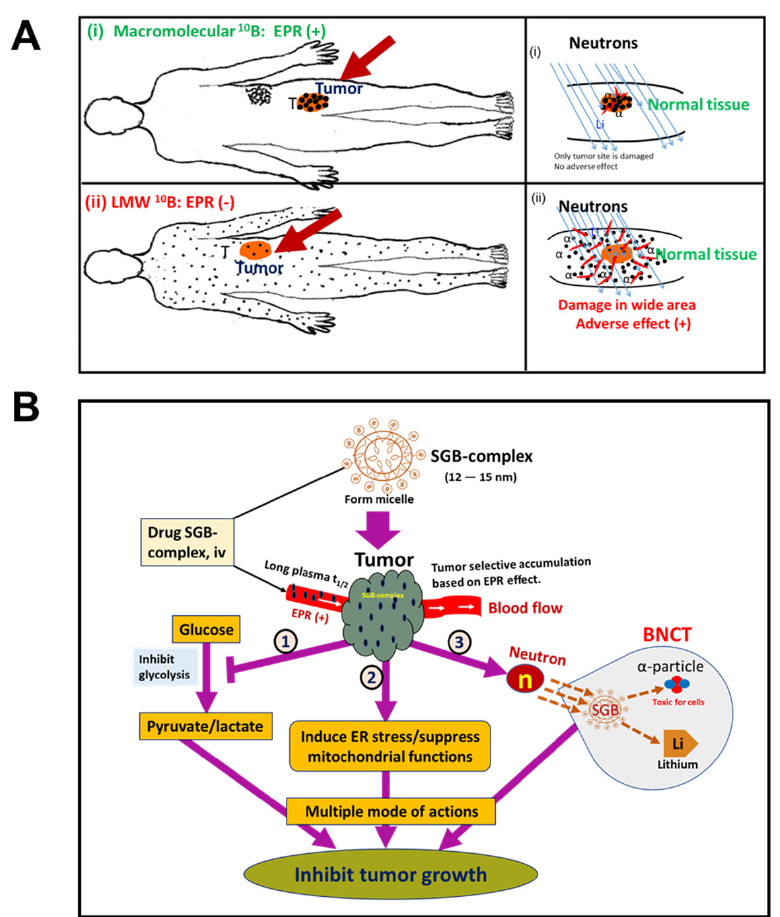
Figure 6. The strategy for successful boron neutron capture therapy (BNCT) ( A ) and multiple modes of actions of the SGB-complex ( B ). The upper panel of ( A ) (i) shows tumor-selective accumulation of a macromolecular borono-drug and α particles only at the tumor site. The lower panel (ii) shows that low-molecular-weight (LMW) drugs are distributed throughout the whole body and produce severe side effects. ( B ) Multiple mechanisms of tumor cell killing by the SGB-complex, which our group developed. ER, endoplasmic reticulum. Please see Islam et al. [70].T he image of ( A ) was taken from the ref. [16] and ( B ) was modified from ref. [68].